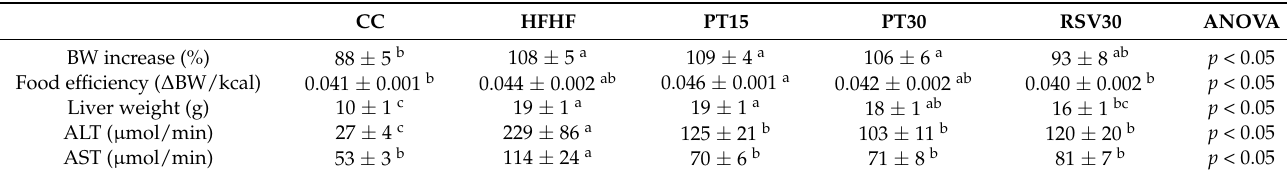
Table 1. Body weight increase, food efficiency, liver weight and serum transaminase levels of rats fed with the experimental diets for 8